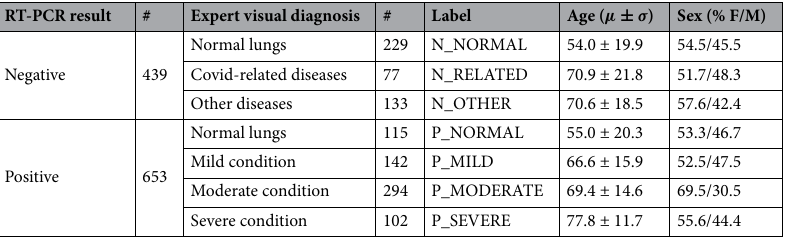
Table 2. Distribution of images in COVID-SC database. F:female; M:male.